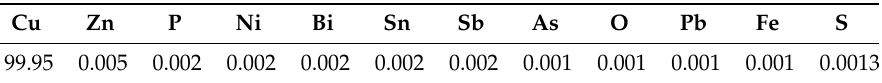
Table 1. The chemical composition of pure copper (wt